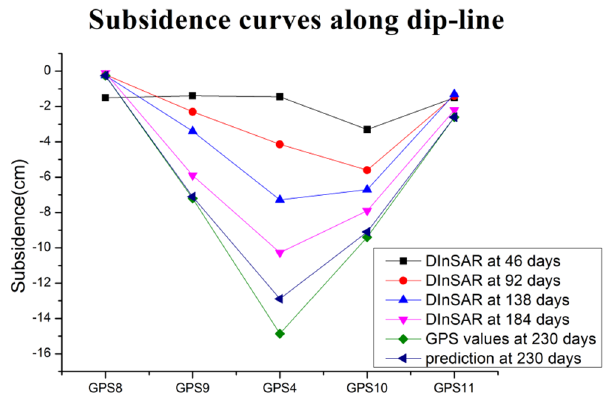
ISPRS Int. J. Geo ‐ Inf. 2019 , 8 , x FOR PEER REVIEW Figure 5. Subsidence curves and prediction results along the strike ‐ line. Figure 5. Subsidence curves and prediction results along the strike-line.